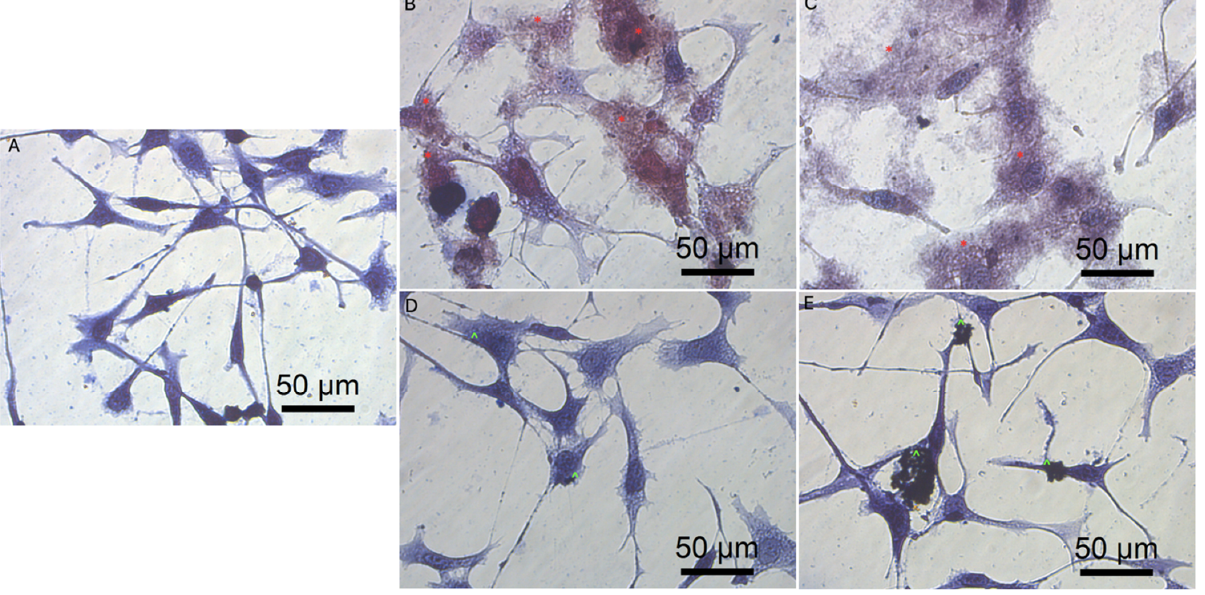
Figure 7. Morphology of U251 glioblastoma cells. ( A ) untreated cells (control group), cells treated with graphene oxide at concentration: 5 µg/mL ( B ), 100 µg/mL ( C ), and reduced graphene oxide at concentration: 5 µg/mL ( D ) and 100 µg/mL ( E ). Red * GO at cell membrane. Green ^ rGO at cell membrane. Light optical microscopy. Scale bars: 50 µm. ( A – E ). Ab- breviations: GO: graphene oxide, rGO: reduced graphene oxide.